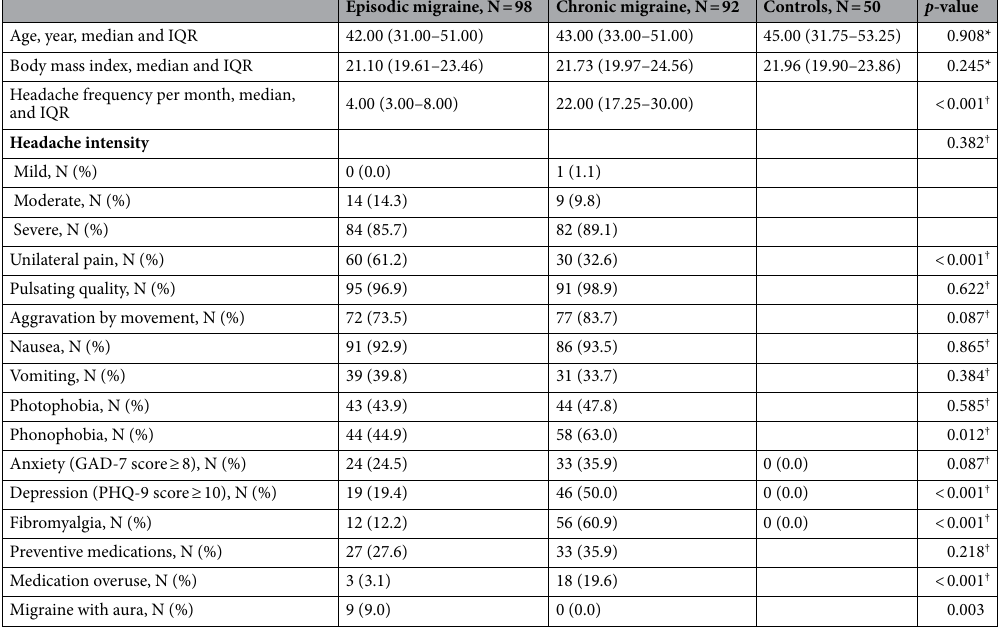
Table 1. Demographic and clinical characteristics of the study participants. GAD-7 Generalized Anxiety Disorder-7, IQR interquartile range, PHQ-9 Patient Health Questionnaire-9. *Comparison among all three groups. † Comparison between participants with episodic and chronic